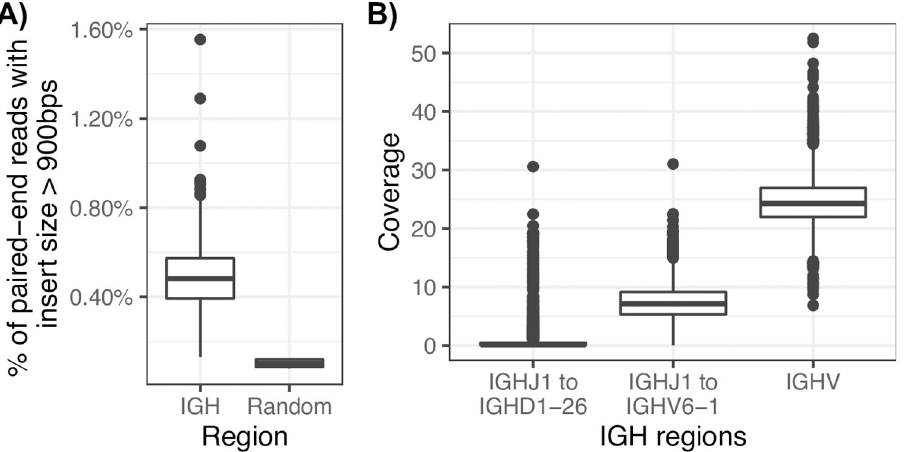
Fig 2. Signatures of V(D)J recombination in paired-end WGS data. (A) Percentage of paired-end read pairs with insert sizes greater than 900 bps in IGH and random genome-wide 1 Mb windows. (B) WGS coverage (1) between IGHJ1 , the IGHJ gene closest to the telomeric end, and IGHD1-26 , the second closest gene to the IGHJ gene cluster; (2) between IGHJ1 and IGHV6-1 , the IGHV gene closest to the IGHD and IGHJ gene cluster; and (3) the entire IGHV